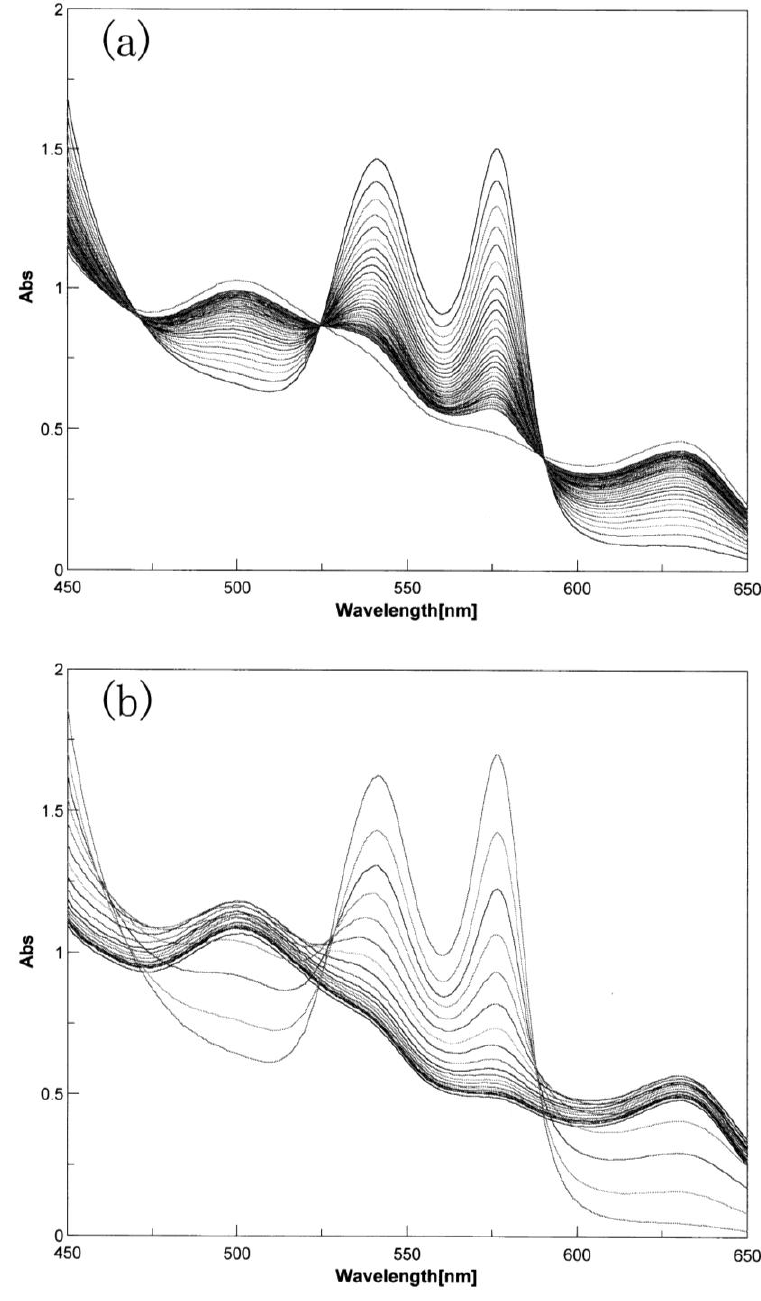
Figure 1. Spectral changes over time associated with hemichrome formation for human HbO A redrawn from Sugawara et al. [13]. (a) Monitoring in 0.1 M MES buffer (pH 5.0) 2 at 37 °C and (b) in 0.1 M MES buffer (pH 6.5) at 40 °C. In case a, hemichrome formation was not detected until the reaction was almost 75% complete. In case b, the emergence of hemichrome due to accumulation and precipitation of soluble and insoluble hemichromes was noticeable by sudden disruption of the recorded spectrum at the final stage (at around 17.5 h) of the time course. Conditions: HbO concentration was 235 μM (in heme 2 contents); and scanning intervals were (a) 15 min and (b) 150